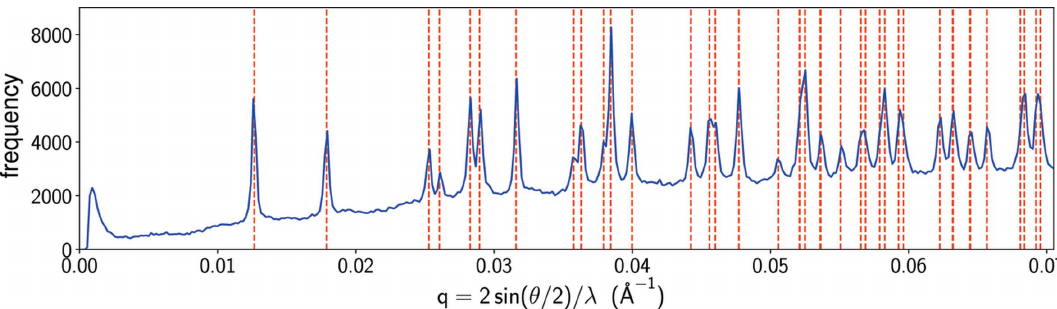
Figure 2 The one-dimensional pseudo-powder pattern generated from the frequency of the inter-peak distances in reciprocal space. Red dashed lines indicate peaks predicted by a primitive tetragonal lattice with lattice parameters a = 79.1 and c = 38.4 A˚ . The peak closest to the origin represents pairs of Bragg- peak candidates that are very close to each other. These pairs are actually fragments of Bragg spots of a larger size.